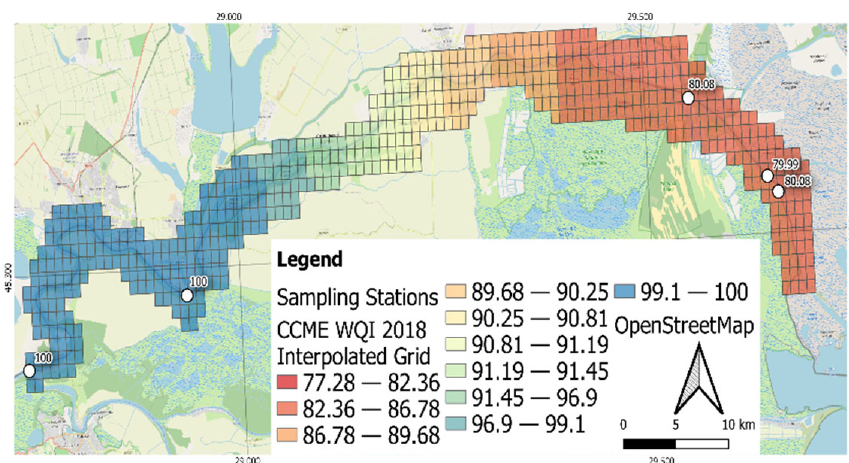
Figure 8. CCME WQI trends in 2017 on the Chilia branch.